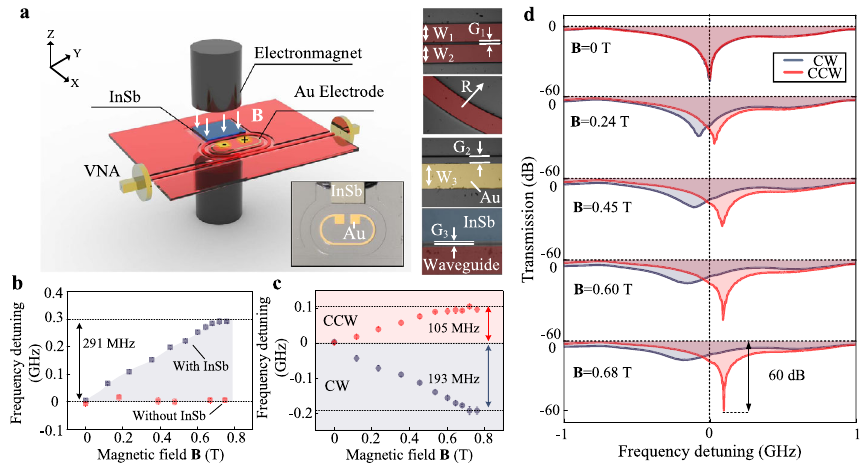
Fig. 2 Experimental veri fi cation of the terahertz nonreciprocity. a The schematic diagram of the experimental setup, and the insets illustrate the photo and optical microscopic images of the chip ( W refers to the width, G refers to the gap, and R refers to radius), including the coupling region of two waveguides (marked in red, W 1 = 294.63 µ m, W 2 = 292.97 µ m, G 1 = 41.68 µ m), the bent waveguide ( R = 4.05 mm), the metal electrode (marked in yellow, W 3 = 314.14 µ m, G 2 = 87.31 µ m), and the coupling region between the waveguide and the InSb (marked in blue, G 3 = 8.76 µ m). b Frequency detuning between CW and CCW directions with the change of the magnetic fi eld. Blue points refer to the chip with InSb, while red points refer to the chip without InSb. c Frequency detuning of the nonreciprocal chip in CW and CCW directions with the change of the magnetic fi eld. d Normalized transmission spectra under different magnetic fi elds. In c and d , Blue points and lines refer to CW direction, while red points and lines refer to CCW direction. The error bars in b and c represent the standard deviations of three measurements of frequency